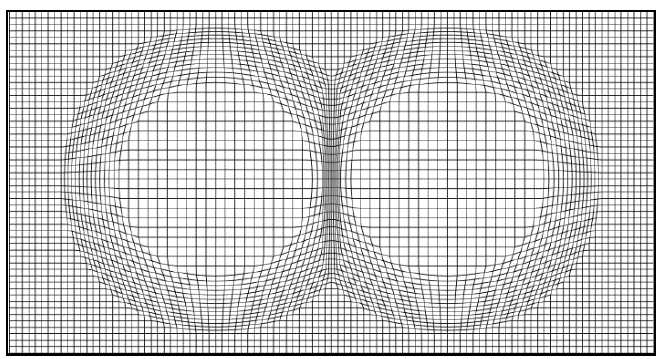
Figure 4. The variable-scale representation with two focus areas.